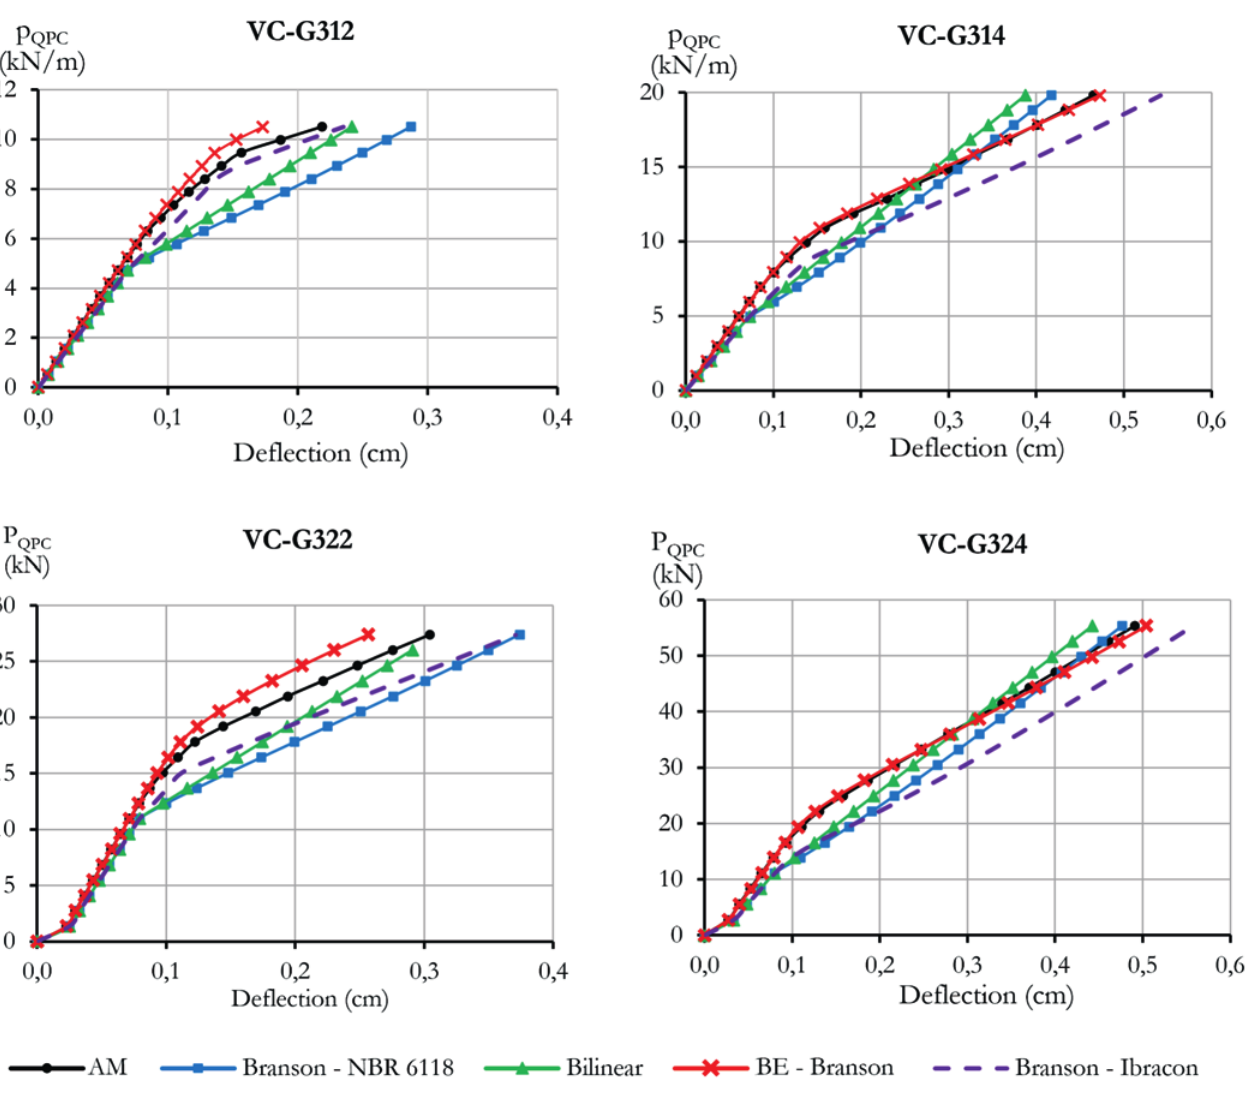
Details of load and longitudinal reinforcement for the beams from groups VCA-G1 and VCA-G2 Beam